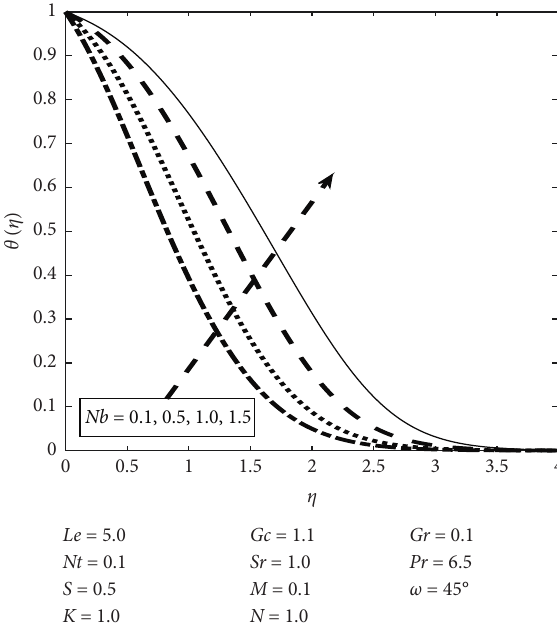
Figure 12: Temperature profile for several values of Nb .